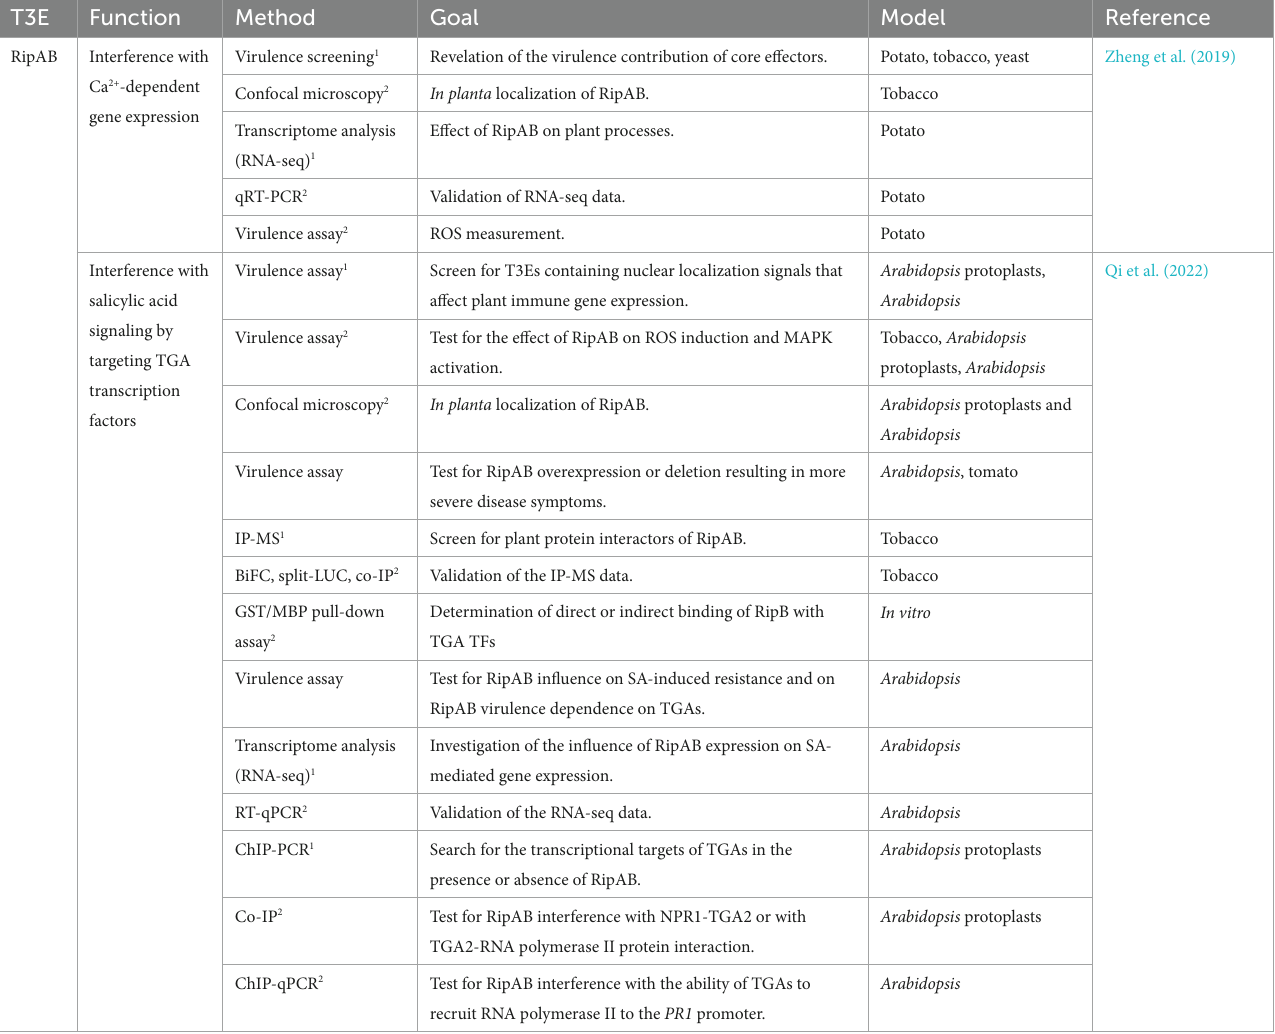
1 Screening method. 2 Validation